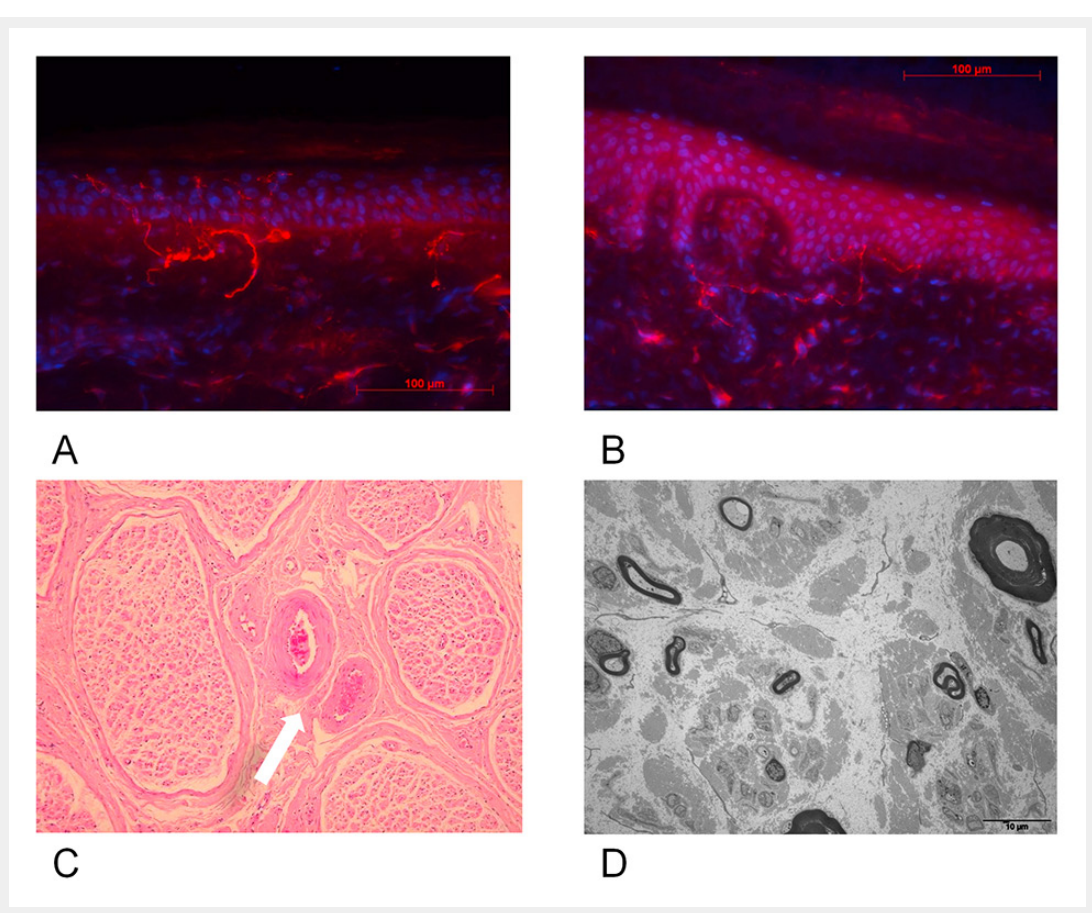
Figure 1 Distal lower limb skin and sural nerve biopsy in normal subject compared with patient 4. A: Distal lower limb biopsy of a normal subject (FO). Magnification 40x. Average intraepidermal nerve fibre density (IENFDd) = 12.7 s/mm. B: Distal lower limb skin biopsy of patient 4. Note rarefaction of intraepidernal nerve fibres. Magnification 40x. Average IENFd = 2.8 s/mm. C: Sural nerve biopsy of patient 4. Optical microspcopy (haematoxylin and eosin staining, orginal magnification 40x). Note microthrombosis of vasa vasorum (white arrow). D: Sural nerve biopsy of patient 4, electron microscopy. Severe loss of myelinated and unmyelinated